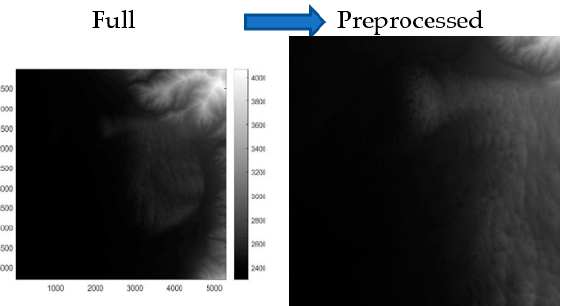
Figure 3. Active sand dunes (Great Sand Dunes, CO, USA) [64]: 1000 × 1000 with pixel size of 9.99 m.